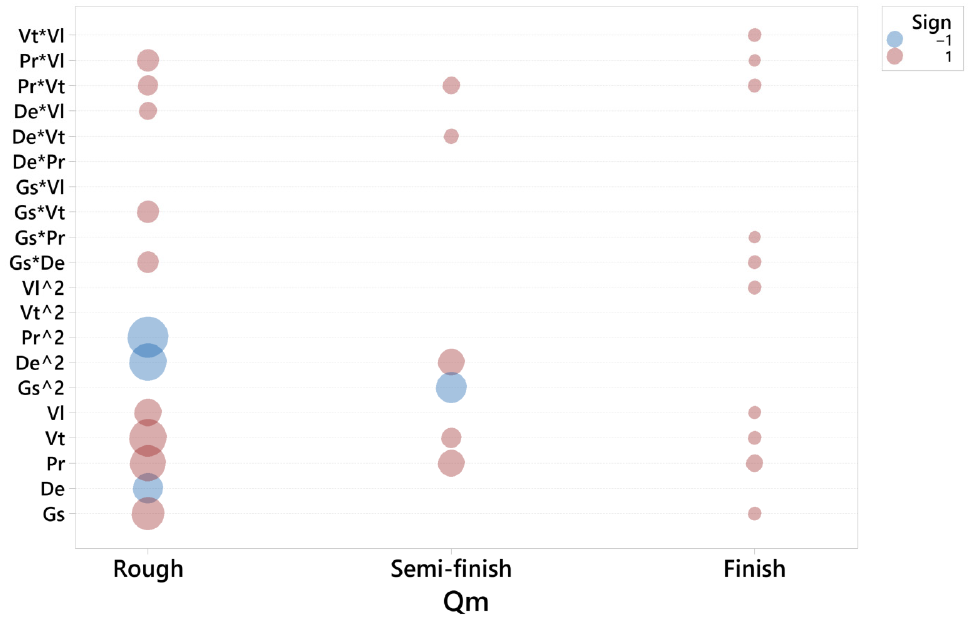
Figure 8. Significant terms for Qm in the rough, semi-finish and finish operations.